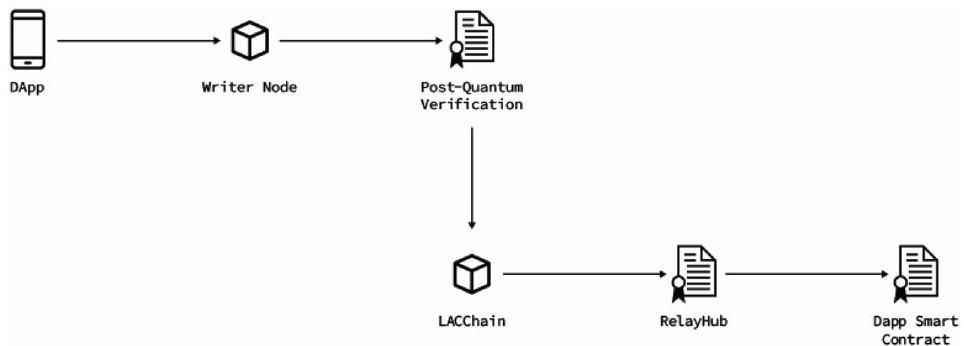
Figure 7. High level diagram presenting the different components from the DApp (it can also be an app or any application connected to the writer node and generating transactions) and the smart contract that it is calling.